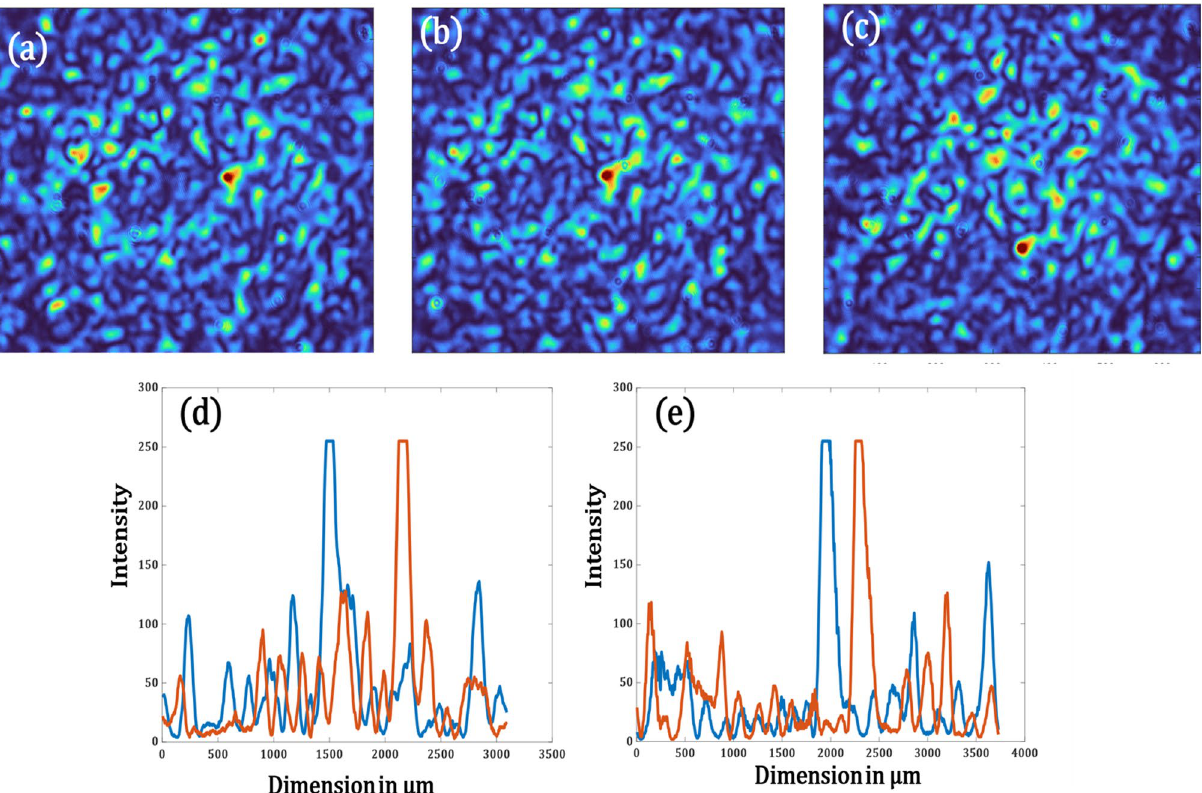
Figure 8. ( a ) Shifted focal spot along x, ( b ) Actual focal spot after optimization, ( c ) Shifted focal spot along y, ( d ) Profile view of ( b ) and ( a ) in blue and red respectively, the plot shows a shift of 348 µm, ( e ) Profile view of ( b ) and ( c ) in blue and red respectively, the plot shows a shift of 667 µm.